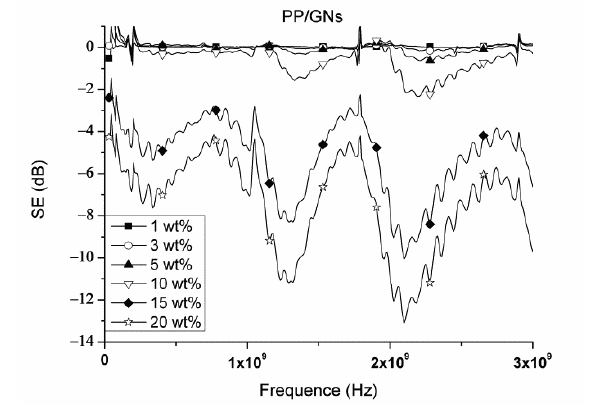
Figure 10. EMI SE of PP/GNs composites with a thickness of 0.5 mm as related to various blending ratios.